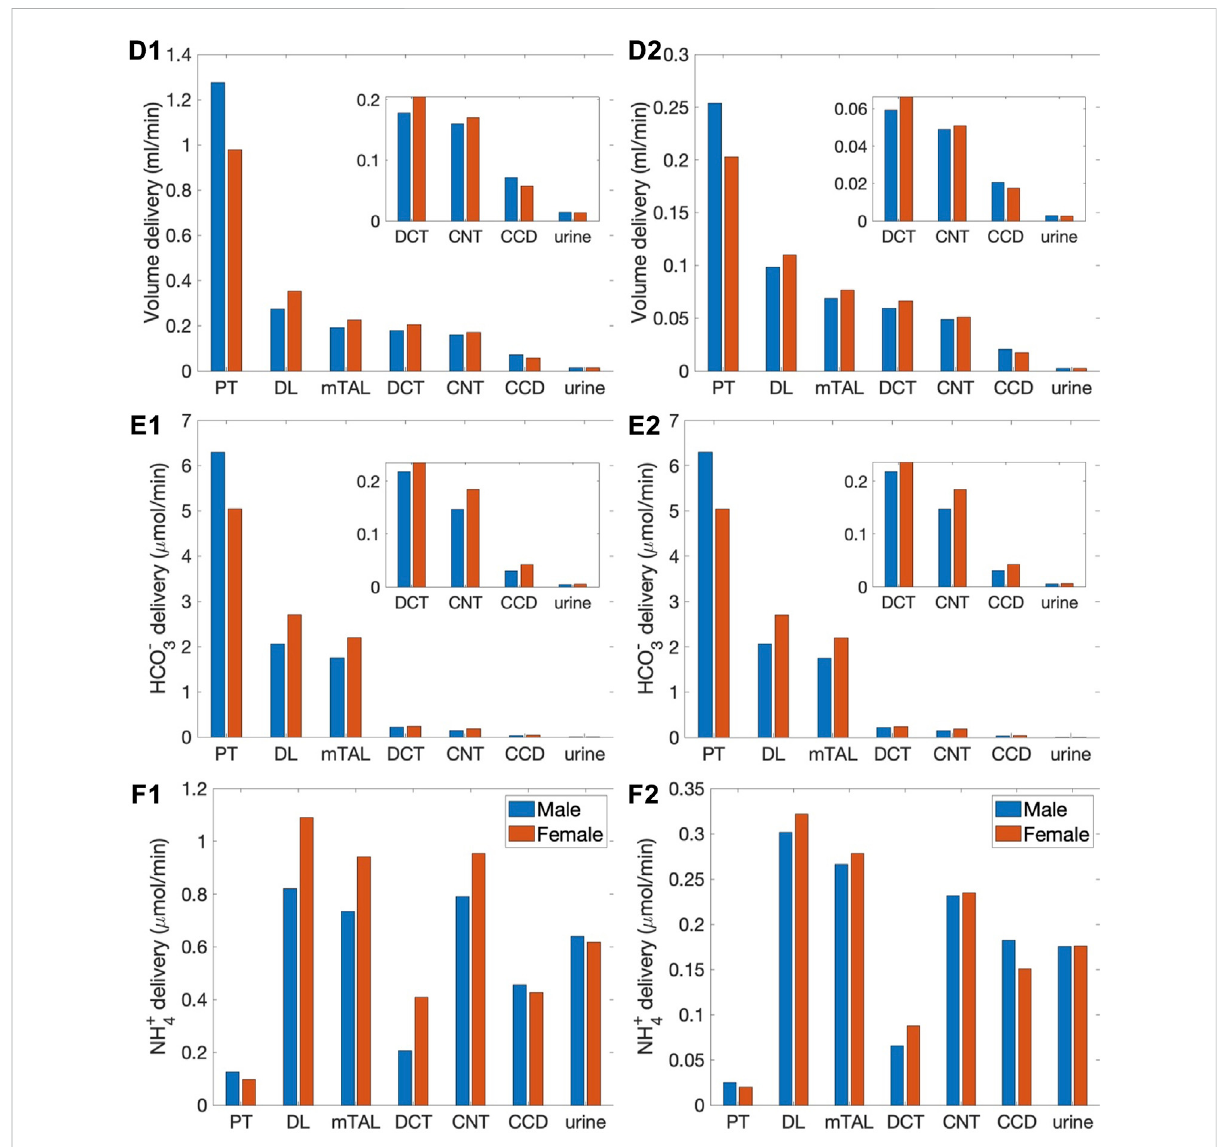
Delivery of key solutes and fl uid to the beginning of individual nephron segments in male and female rats ( A1 , B1 , C1 , D1 , E1 , F1 ) and mice ( A2 , B2 , C2 , D2 , E2 , F2 ). Flows along super fi cial and juxtamedullary are scaled by their population and added together. The rightmost sets of bars show urine excretion rates. PT, proximal tubule; DL, descending limb; mTAL, medullary thick ascending limb; DCT, distal convoluted tubule; CNT, connecting tubule; CCD, cortical collecting duct. Insets: magni fi ed reproductions of distal segment values. The difference between in fl ow of consecutive segments corresponds to net transport along that segment. Notably proximal tubules mediate signi fi cantly more solute and water transport in rats than mice; and within each species, more in males than